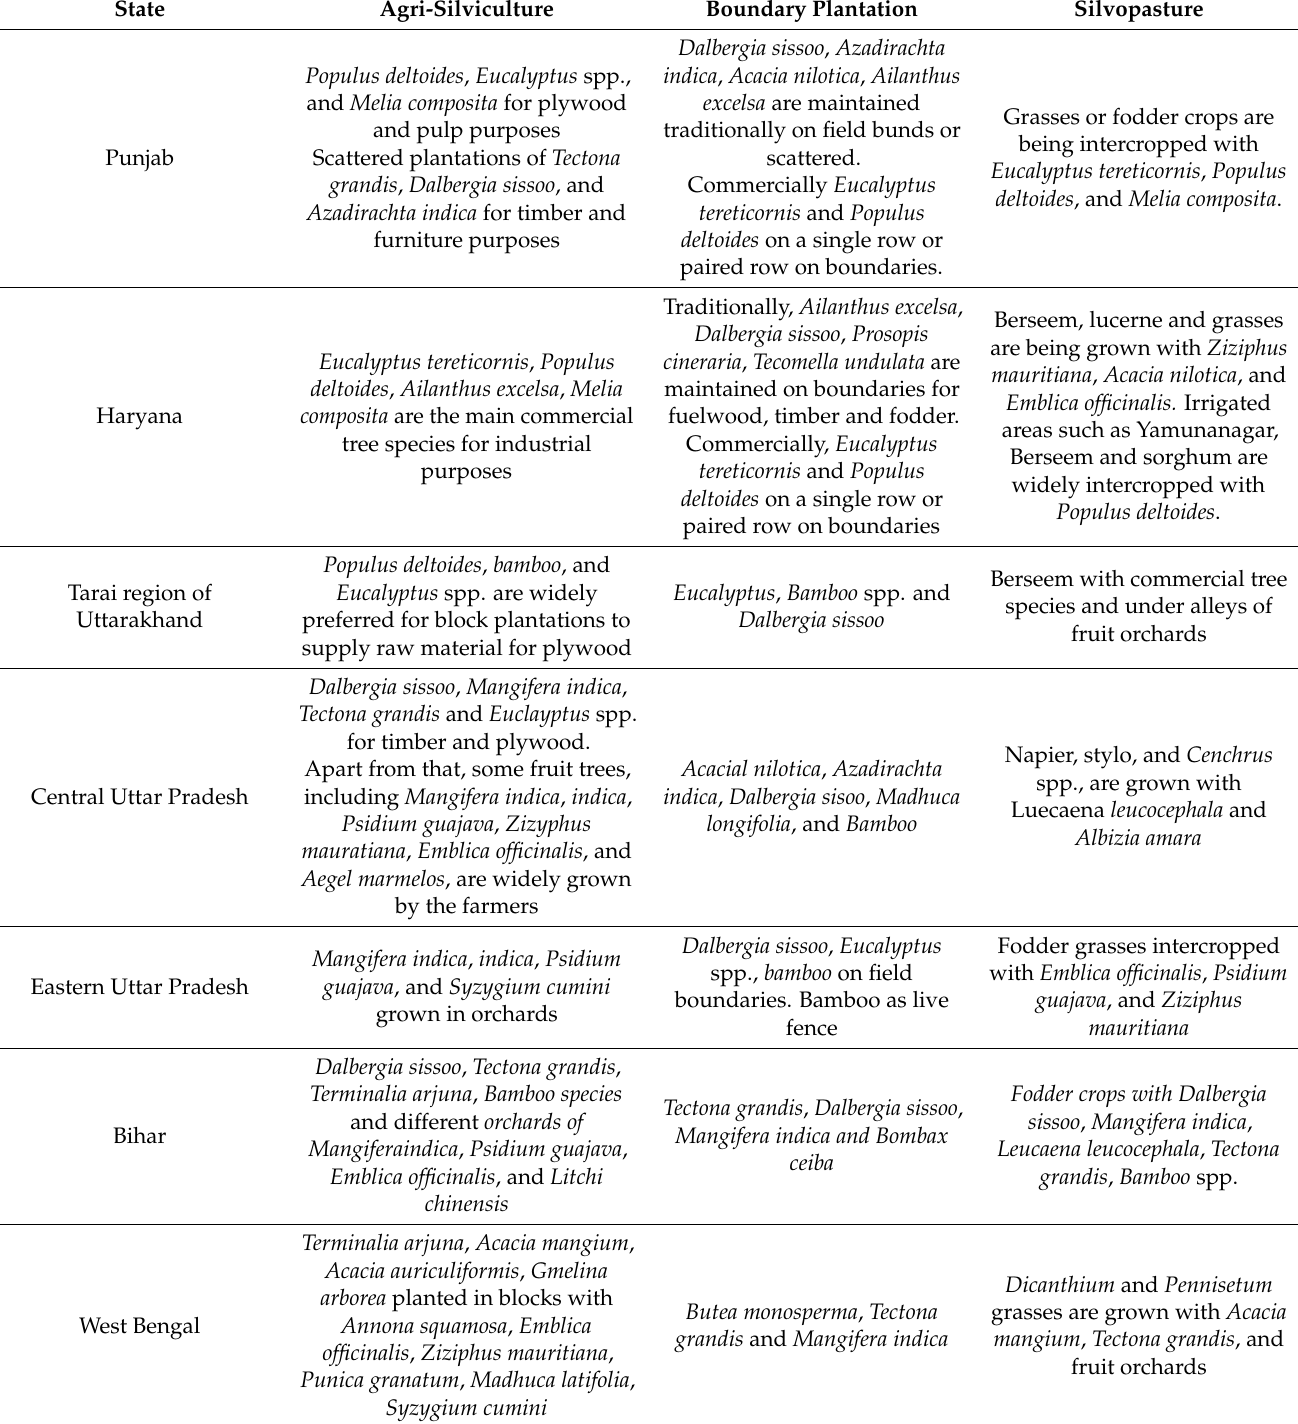
Table 2. Important agroforestry systems of the Indo-Gangetic